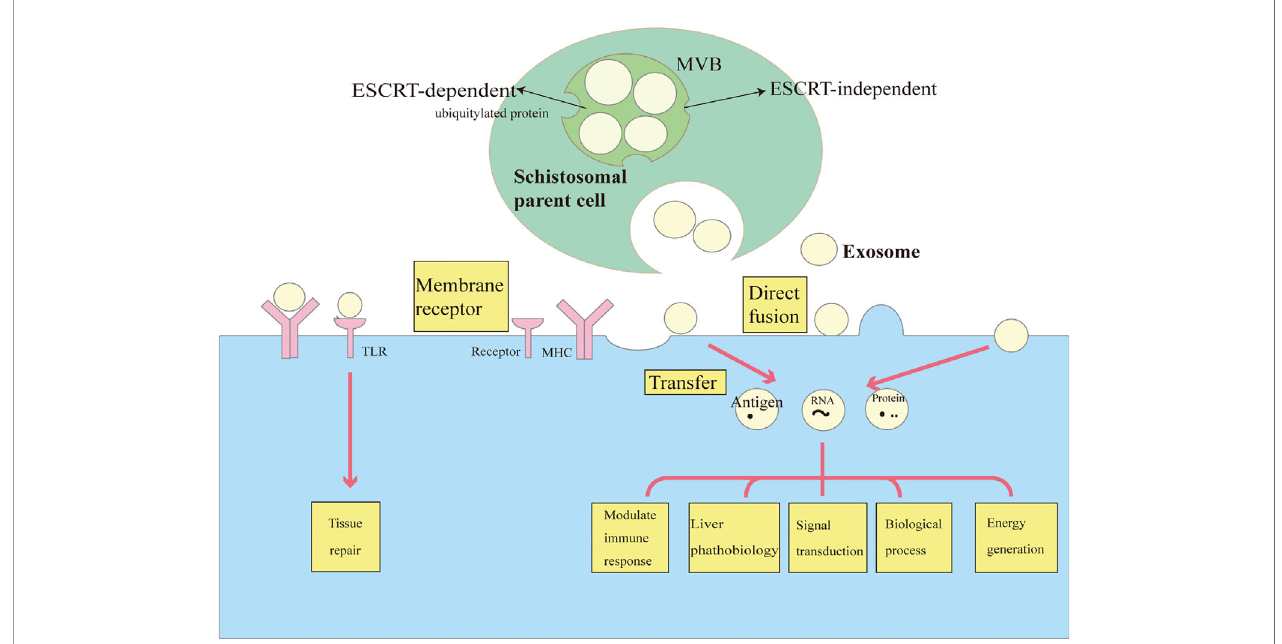
FIGURE 1 | The biology and functions of exosomes in schistosomiasis. Exosomes are vesicles that are formed by the inward budding of the multivesicular body (MVB) membrane. Cargo sorting systems include an ESCRT -dependent pathway (especially for ubiquitylated protein) and an ESCRT-independent pathway (e.g., lipid raft-mediated and ceramide-dependent pathways). Exosomes are secreted following MVB fusion with the cell membrane. Exosomes interact with and are taken up by target cells in different ways, including receptor-mediated endocytosis and direct fusion with the plasma membrane. Exosomes can be regarded as delivering vehicles for several biological processes in schistosomiasis. They transfer antigens, proteins and RNA to modulate immune responses, gene expression, and metabolic processes. Exosomes are also involved in the transfer of lipids to recognize TLRs, thus participating in tissue